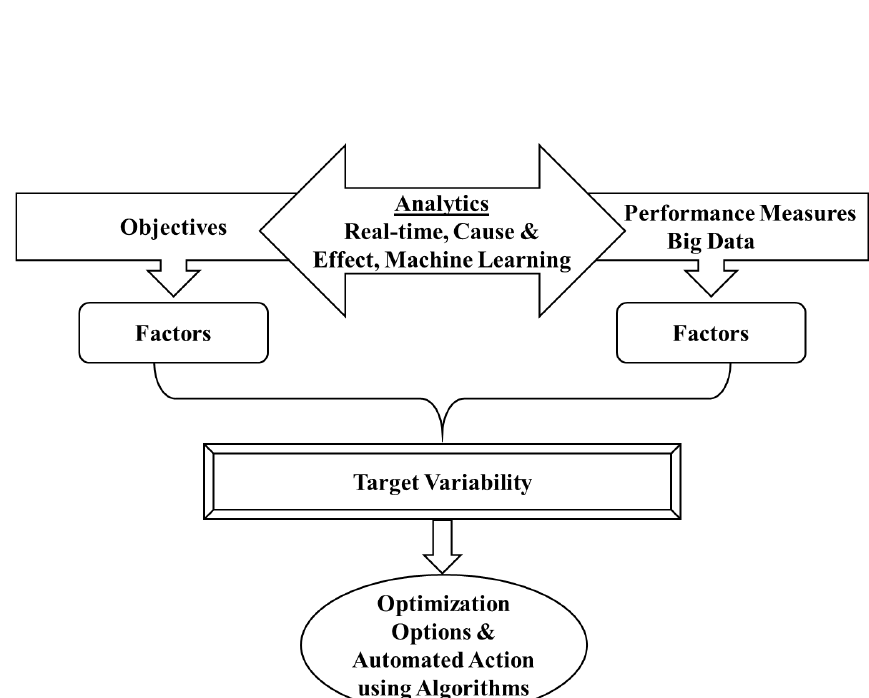
Fig. 14. Strategy Map and Balanced Scorecard Applying Big Data